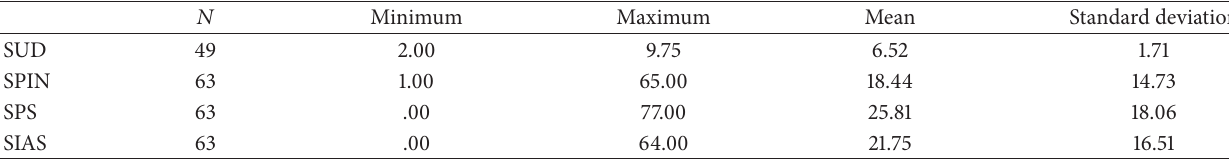
Table 2: Descriptive statistics for SUD ratings and social anxiety